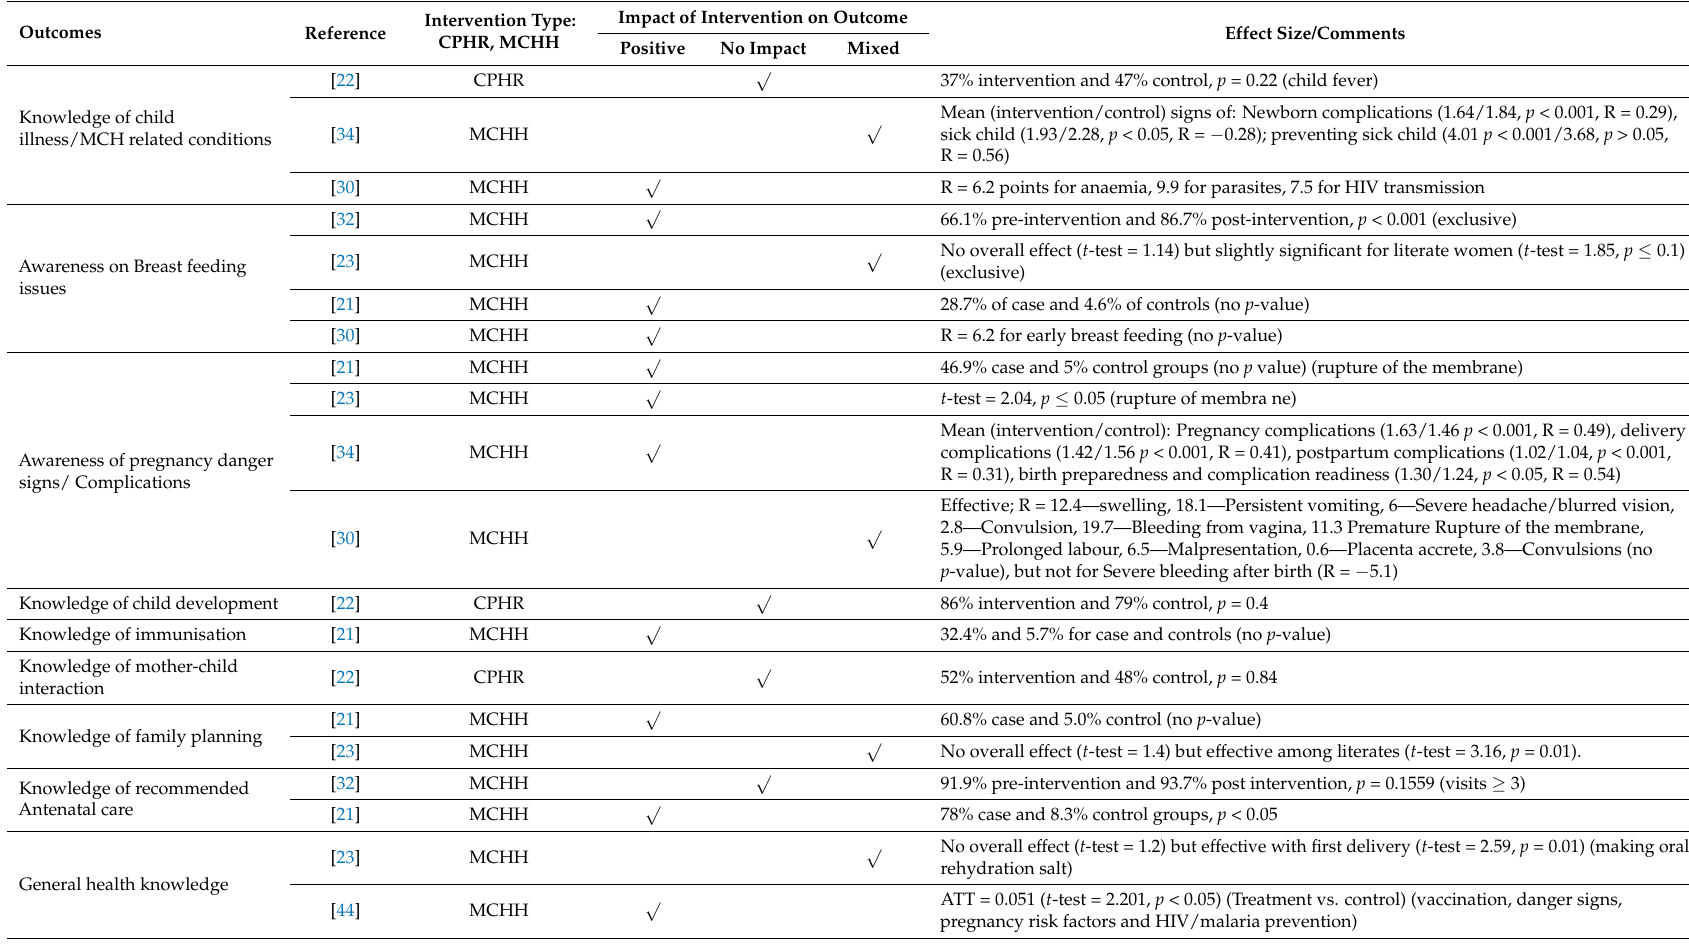
Table 3. Impact of intervention (PHCHR) on parent health